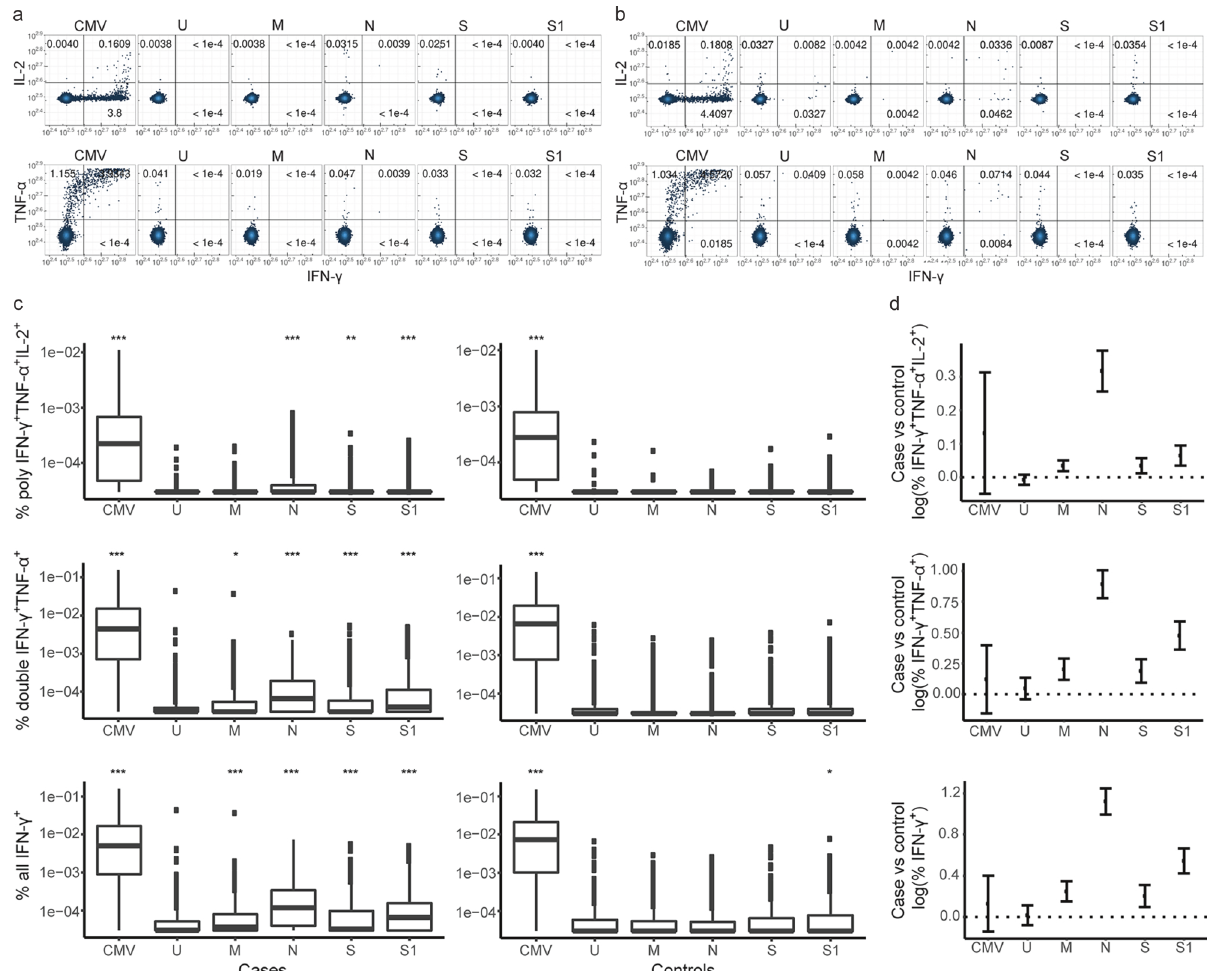
Fig. 2 IFN- γ secreting CD8 + T-cell responses are most strongly induced against the N protein. Representative fl ow cytometry plots showing the cytokine response of SARS-CoV-2 reactive CD8 + T-cells from a an uninfected control and b a SARS-CoV-2 case for all stimulation conditions. The a uninfected control (sampled before March 2020) and b case (sampled after March 2020) samples come from the same individual. c Box plots show the frequencies of each CD8 + T-cell functional phenotype responding to the different stimulation conditions in SARS-CoV-2 cases ( n = 764) and uninfected controls collected during the pandemic ( n = 387). Polyfunctional (IFN- γ + TNF- α + IL-2 + ) and double-positive (IFN- γ + TNF- α + ), as well as all IFN- γ + CD8 + T-cells, are shown. The bottom and top of the boxes correspond to the 25th (Q1) and 75th (Q3) percentiles, the line inside the box corresponds to the median, and the whiskers are located at max(min(Expression), Q1 – 1.5 IQR) and min(max(Expression), Q3 + 1.5 IQR), respectively (where IQR is the interquartile range = Q3 – Q1). * P < 0.05 and *** P < 0.001 for indicated stimulation condition compared with unstimulated culture (U). d The plots show estimates for the difference in the logarithm of the percentage of polyfunctional, double-positive IFN- γ + TNF- α + as well as all INF- γ + CD8 + T-cells within the total CD8 + T-cell population responding to the different stimulation conditions between cases ( n = 764) and controls collected during the pandemic ( n = 387). The error bars indicate 95% con fi dence intervals (CI). The different stimulation conditions are a positive control (CMV), unstimulated control (U), and the four different SARS-CoV-2 proteins (M, N, S, and S1). See also Supplementary Table 3. Association between T-cell responses in different groups was tested by linear regression and signi fi cance was assessed with the standard linear regression t